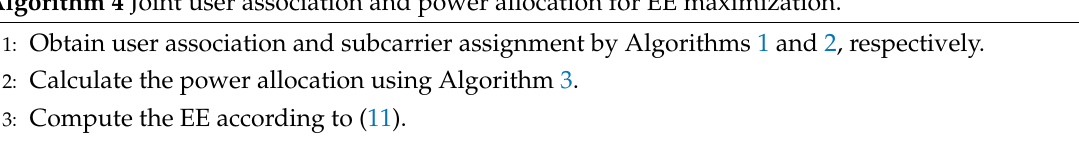
Algorithm 4 Joint user association and power allocation for EE maximization.